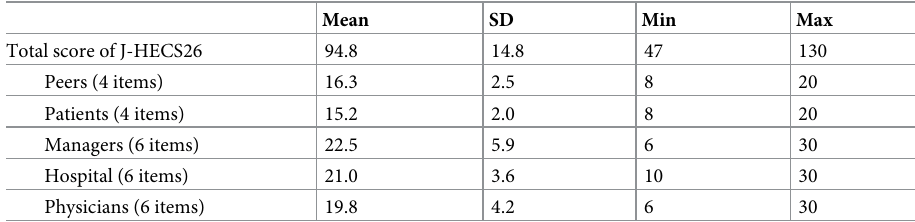
Table 2. J-HECS26 score (n =